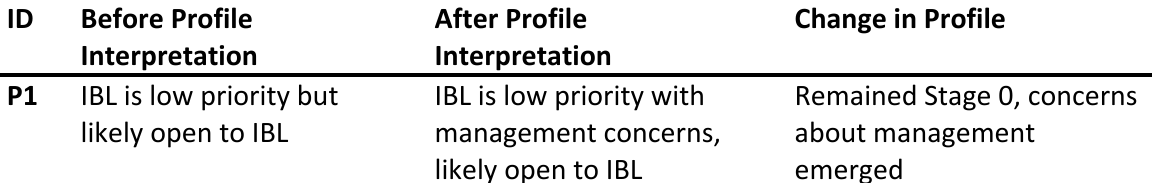
Summary of Before and After SOCQ Profile Interpretations and Profile Changes for Individual Professional Development Program